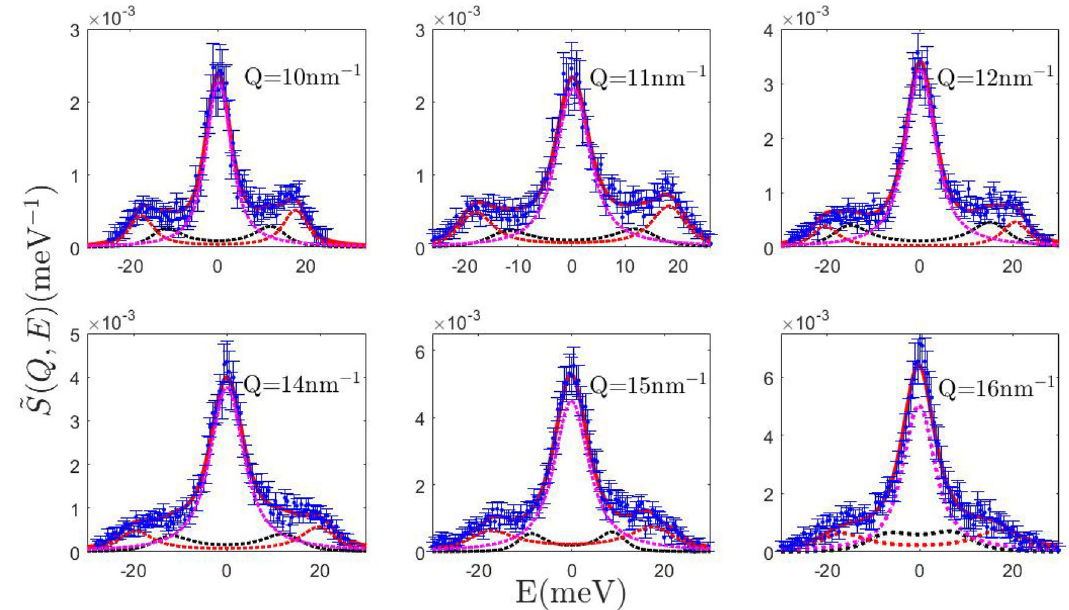
Figure 5. Dynamic structure factor of silver at six selected Q values. The experimental data points are affected by resolution broadening. The corresponding best fit (solid red line) obtained by the MCMC-RJ algorithm for the k = 2 model has been carried out considering the detailed balance asymmetry and finite resolution. The black and the red dotted lines are the low- and the high-frequency DHO components respectively while the pink dotted line is again the Lorentzian